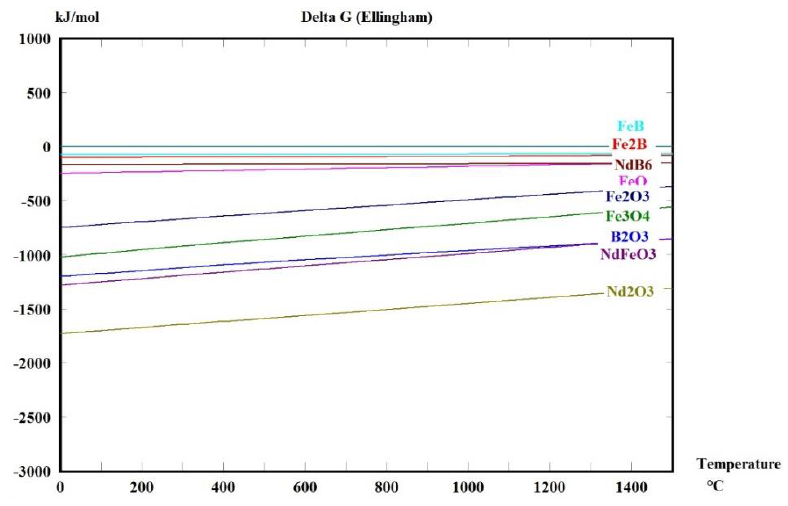
Figure 2. Phase formation during oxidation of the NdFeB